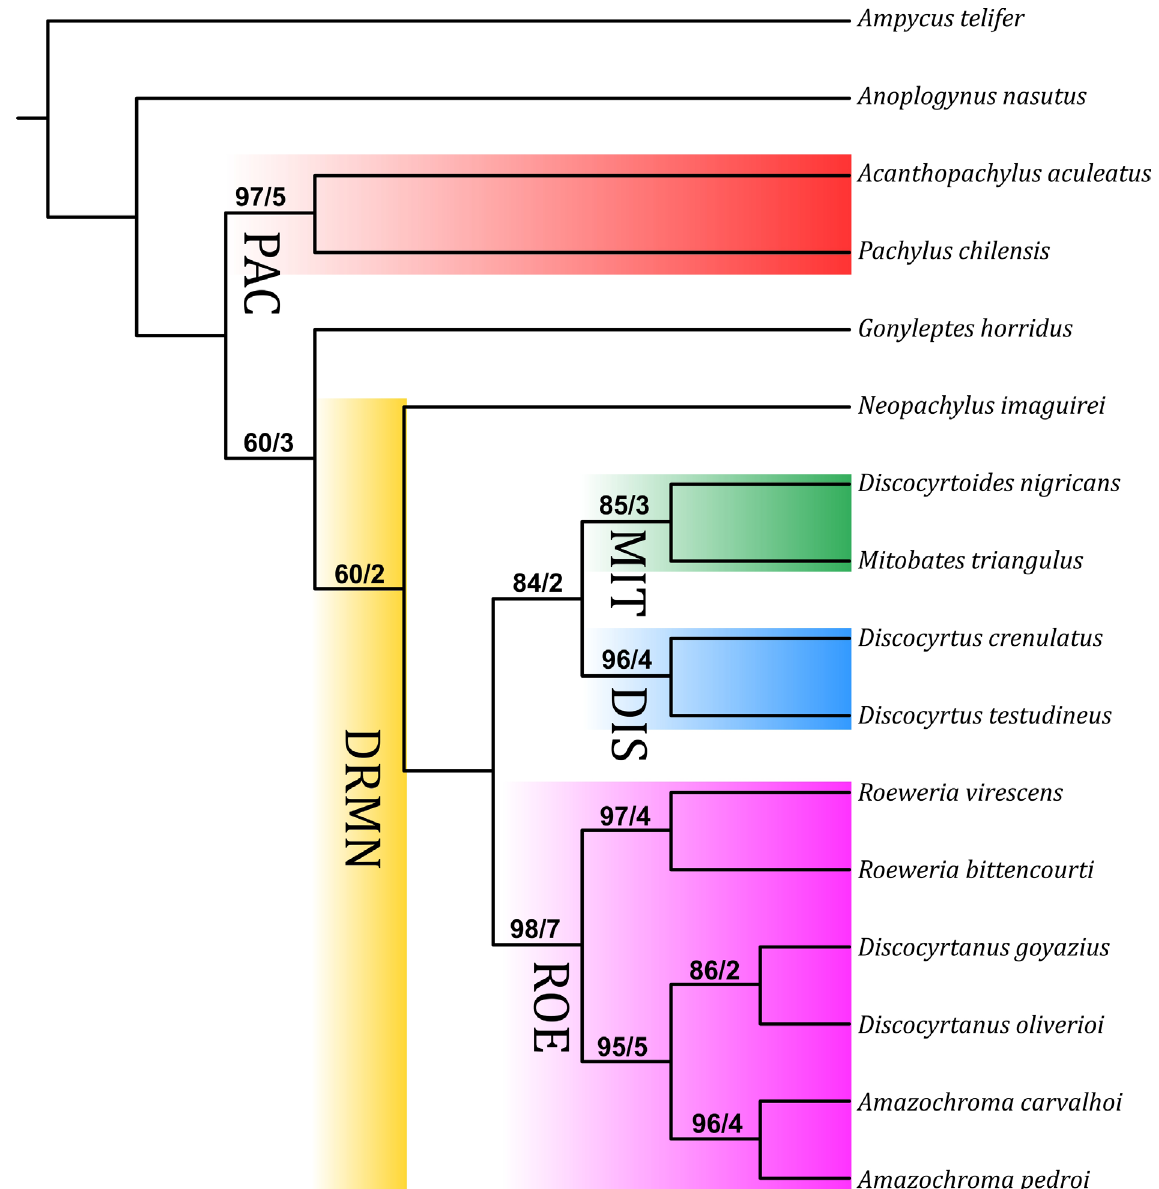
Fig. 4. Single MP tree from TNT. Numbers at branches are the stability from absolute symmetric frequencies resampling percentage values (cut = 50) / decay index from Bremer Support. Abbreviations and colored backgrounds codes are: PAC (red) = Pachylinae; DRMN (yellow) = Monophyletic group including Discocyrtus , Roeweriinae subfam. nov., and Mitobatinae; MIT (green) = Mitobatinae; DIS (blue) = Discocyrtus; ROE (magenta) = Roeweriinae subfam.